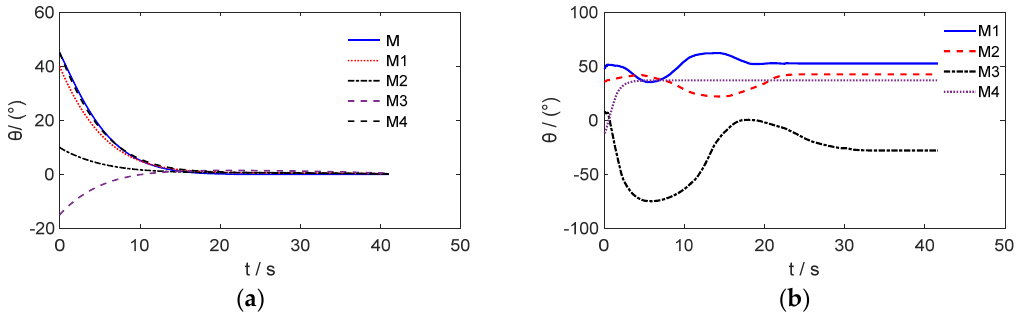
Figure 17. Comparison of the trajectory inclination curves of each follower missile between the proposed guidance scheme and the time cooperative guidance scheme: ( a ) Time cooperative guidance law; ( b ) MPC-based cooperative guidance law.